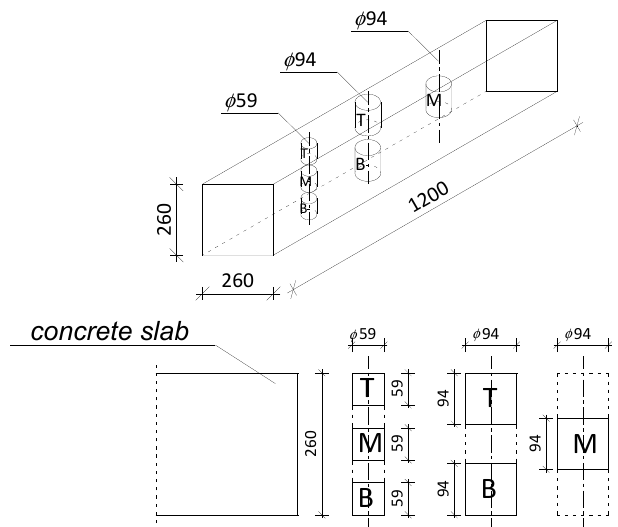
Figure 2. Slab with layers in which the compressive strength of the concrete was tested. T—top layer, M—middle layer, B—bottom layer.